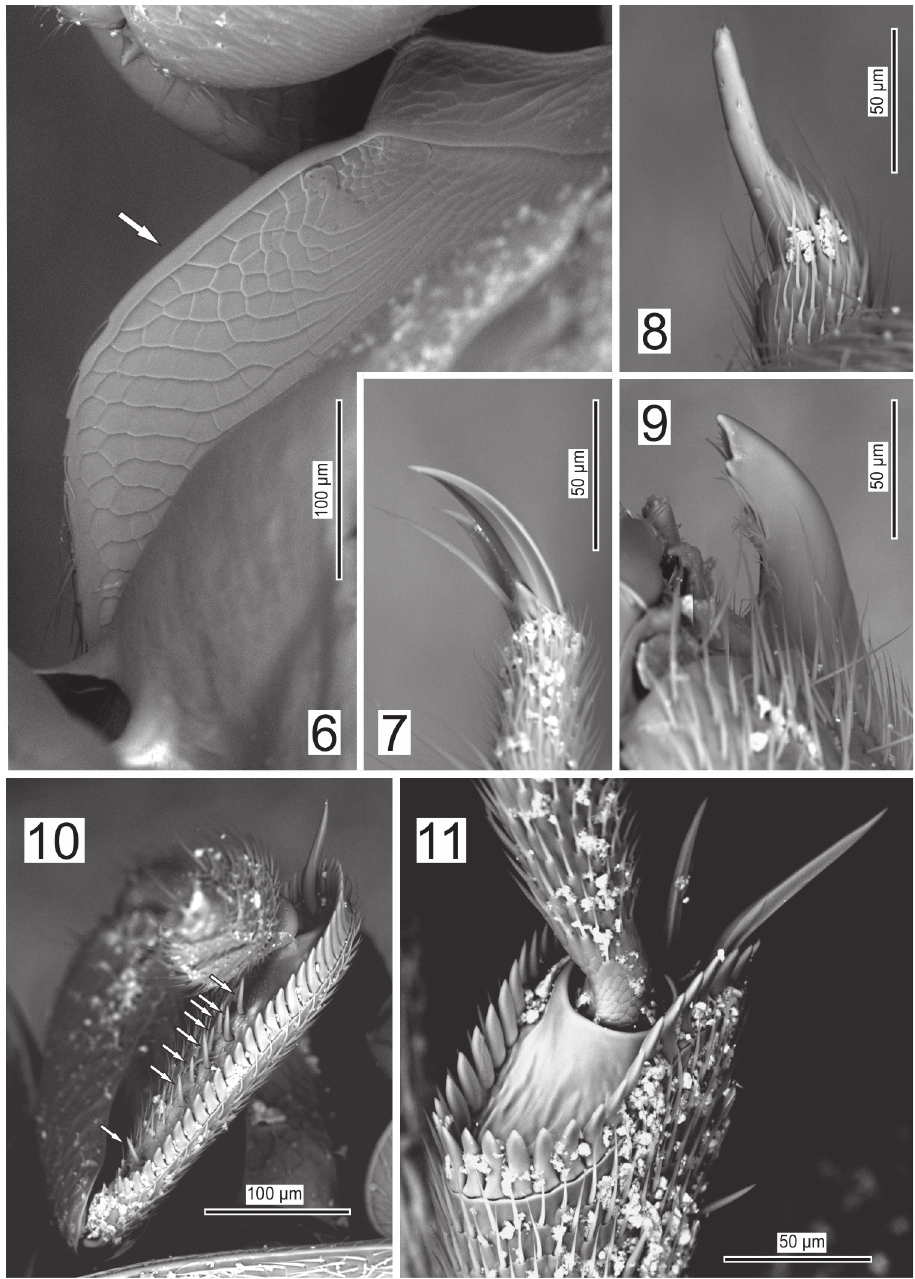
Figures 6–11. Ptomaphaginus troglodytes sp. n., male holotype from Shuiboshu Dong cave, SEM. 6 mes- oventral process in lateral view 7 apex of mesotarsus in lateral view 8 apex of maxillary palpus in dorsal view 9 right mandibula in dorsal view 10 left protibia in lateral view (arrows indicate position of spines on ventral side) 11 apex of mesotibia in dorso-posterior